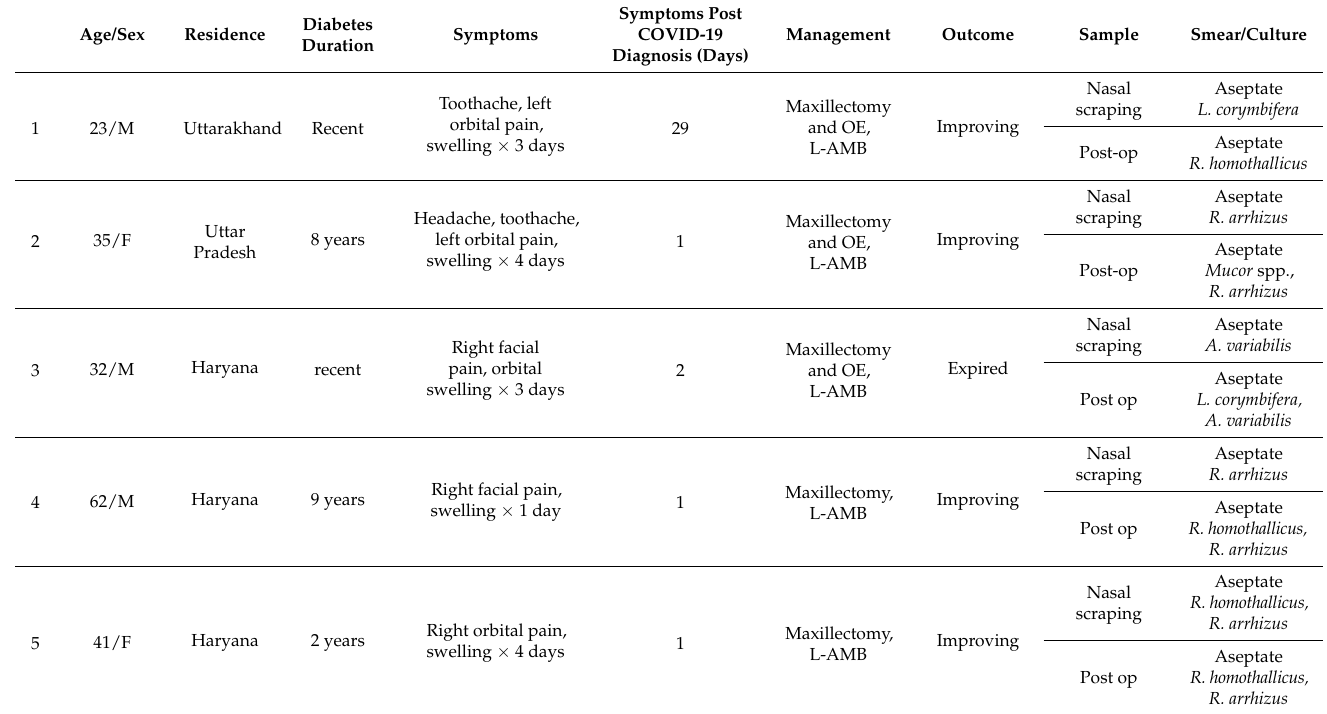
Image 1: Calcoflour white potassium hydroxide mount showing flourescing aseptate, ribbon like hyphae of Mucorales ( × 400) Image 2: Sabouraud dextrose agar showing mixed culture of R. arrhizus (greyish black fluffy growth on the left) and Mucor spp. (yellowish black fluffy growth in left and right tubes). Table 1. Demographic, clinical and mycological details of cases of mixed Mucorales